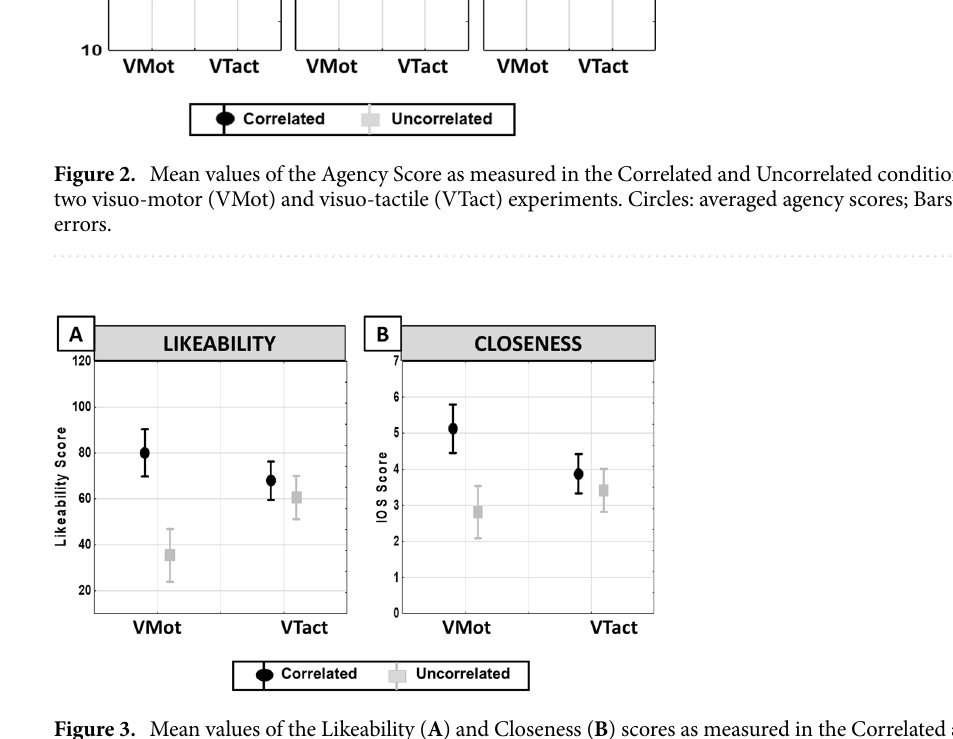
Figure 3. Mean values of the Likeability ( A ) and Closeness ( B ) scores as measured in the Correlated and Uncorrelated conditions in visuo-motor (VMot) and visuo-tactile (VTact) experiments. Circles: averaged scores of likeability and closeness; Bars: standard